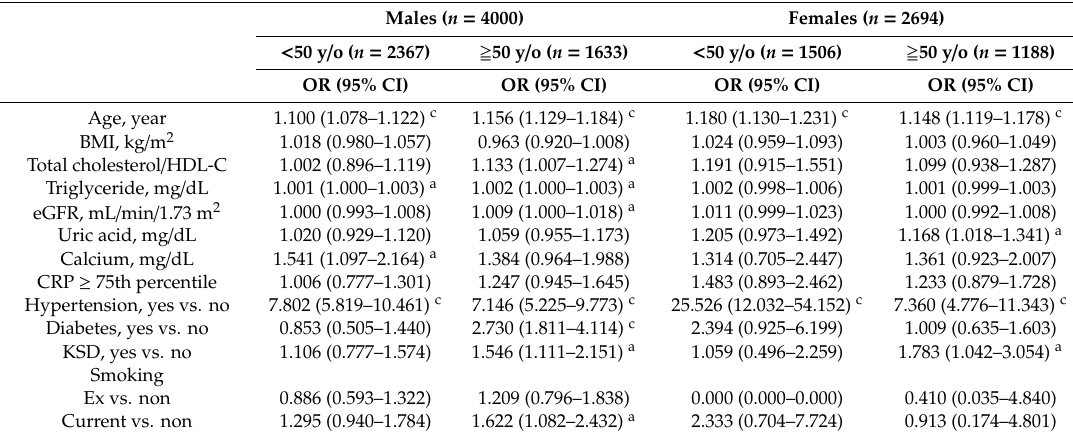
Table 4. Multiple logistic regression analyses for the relationship of KSD and other clinical variables with increased arterial sti ff ness by age and gender